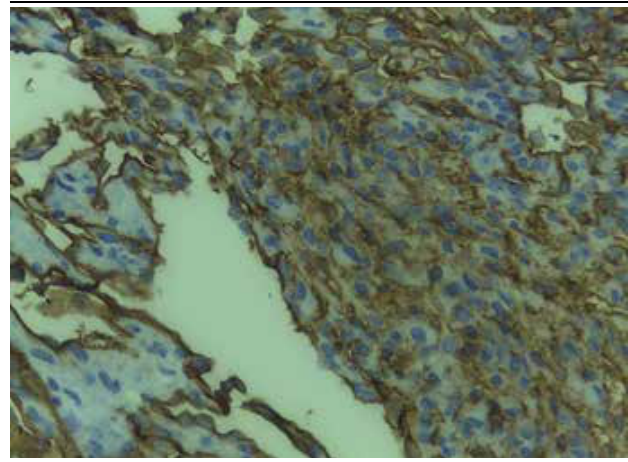
figuRE 7 − Immunohistochemistry showing lesion positive for CD34 (400×) CD34: cluster of differentiation